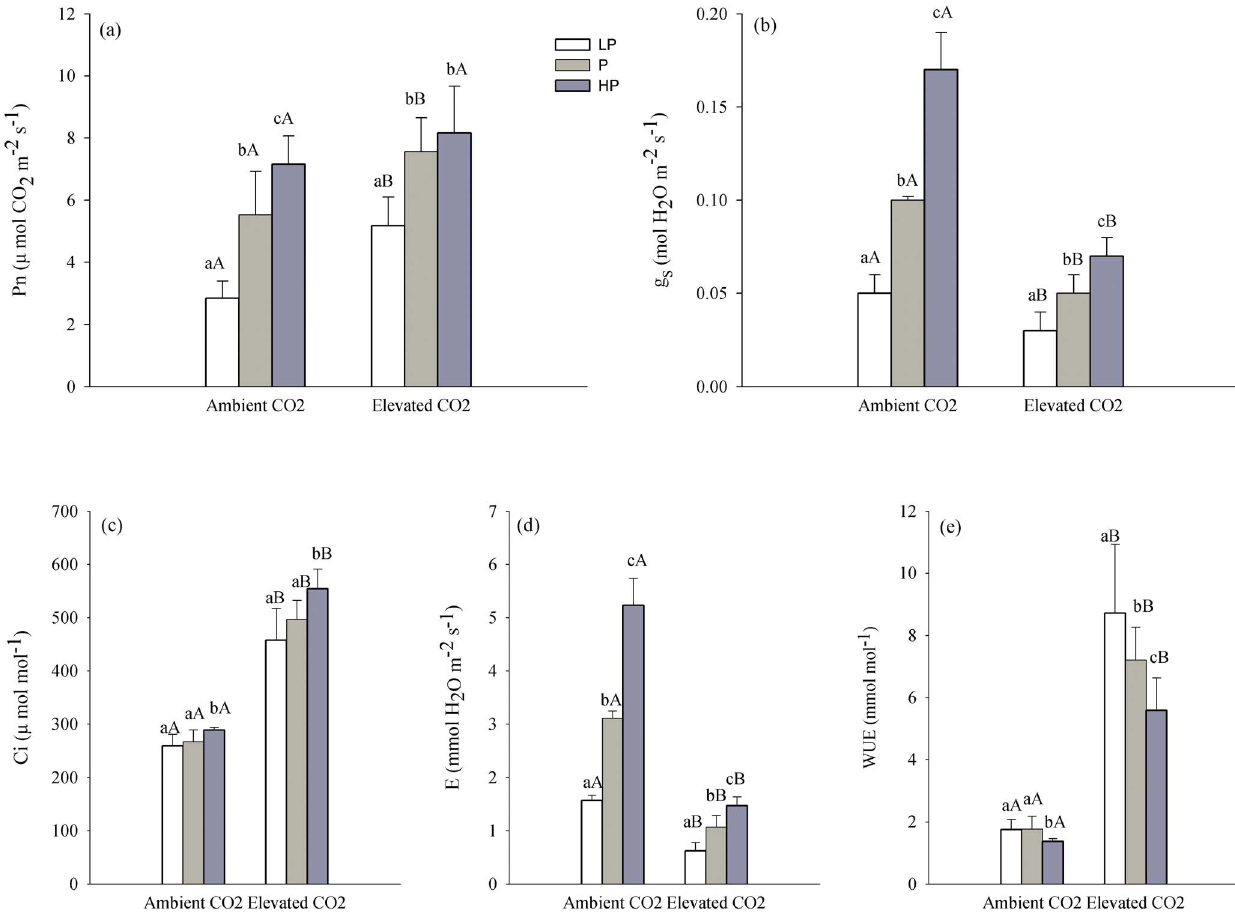
Figure 4. Effect of precipitation on photosynthetic rate ( P n ), stomatal conductance ( g s ), intercellular CO 2 concentration ( C i), transpiration rate ( E ) and water use efficiency ( WUE ) of Leymuschinensis under two CO 2 concentrations. Different lower-case letters indicate a significant difference among different levels of precipitation and different capital letters indicate a significant difference between the two CO 2 levels ( P , 0.05). LP, P, HP represents low precipitation ( 2 40%), normal precipitation and high precipitation ( + 40%), respectively. doi:10.1371/journal.pone.0103633.g004 Elevated CO 2 can directly increase the carboxylation efficiency climbed to 80% or more, so above-ground biomass per plant of C 3 species, or induce stomatal closure and then limit the rate of transpiration indirectly, causing an increase in WUE [31], [40]. high level (Table 2). A similar trend was observed in P n . Table 2. Effect of precipitation on biomass of L. Chinensis under two CO 2 concentrations.